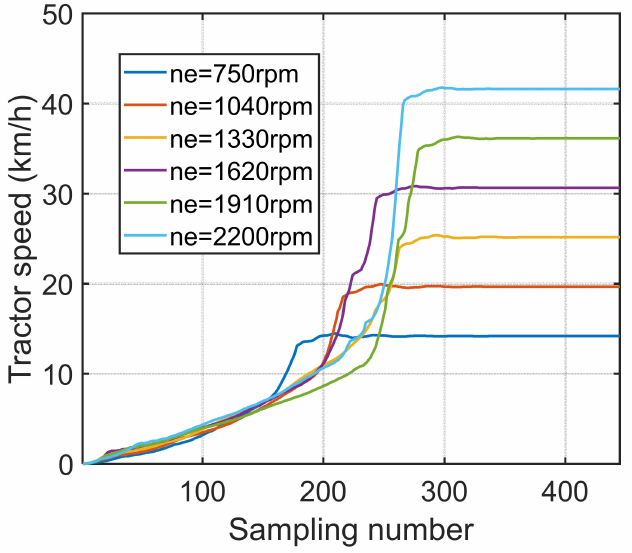
Figure 9. Simulation results of tractor